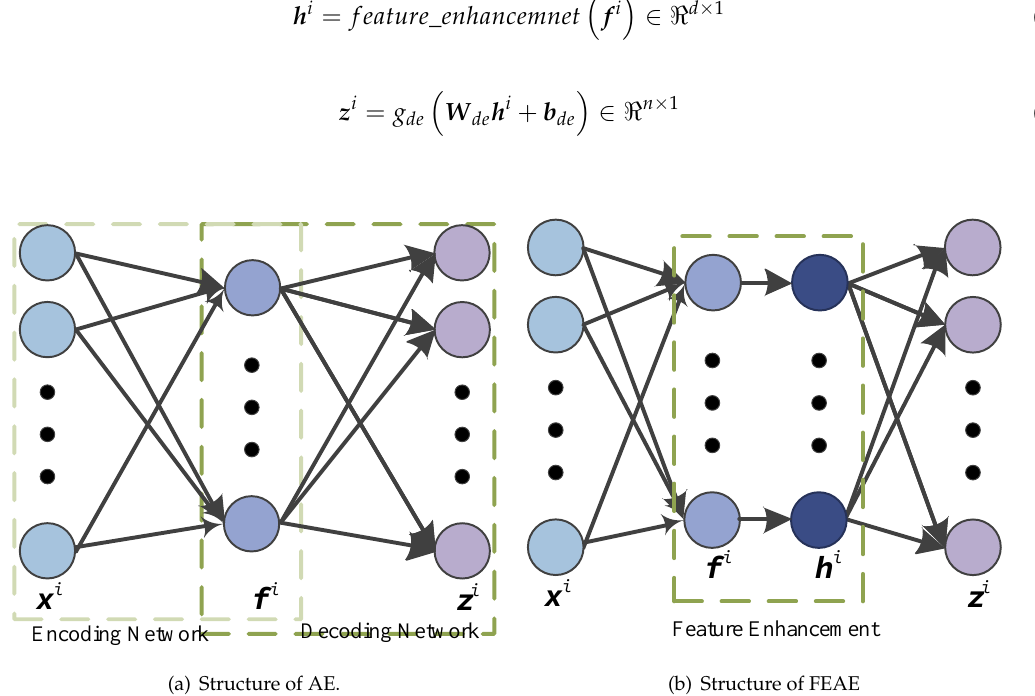
Figure 1. Structures of autoencoder (AE) and feature enhanced autoencoder